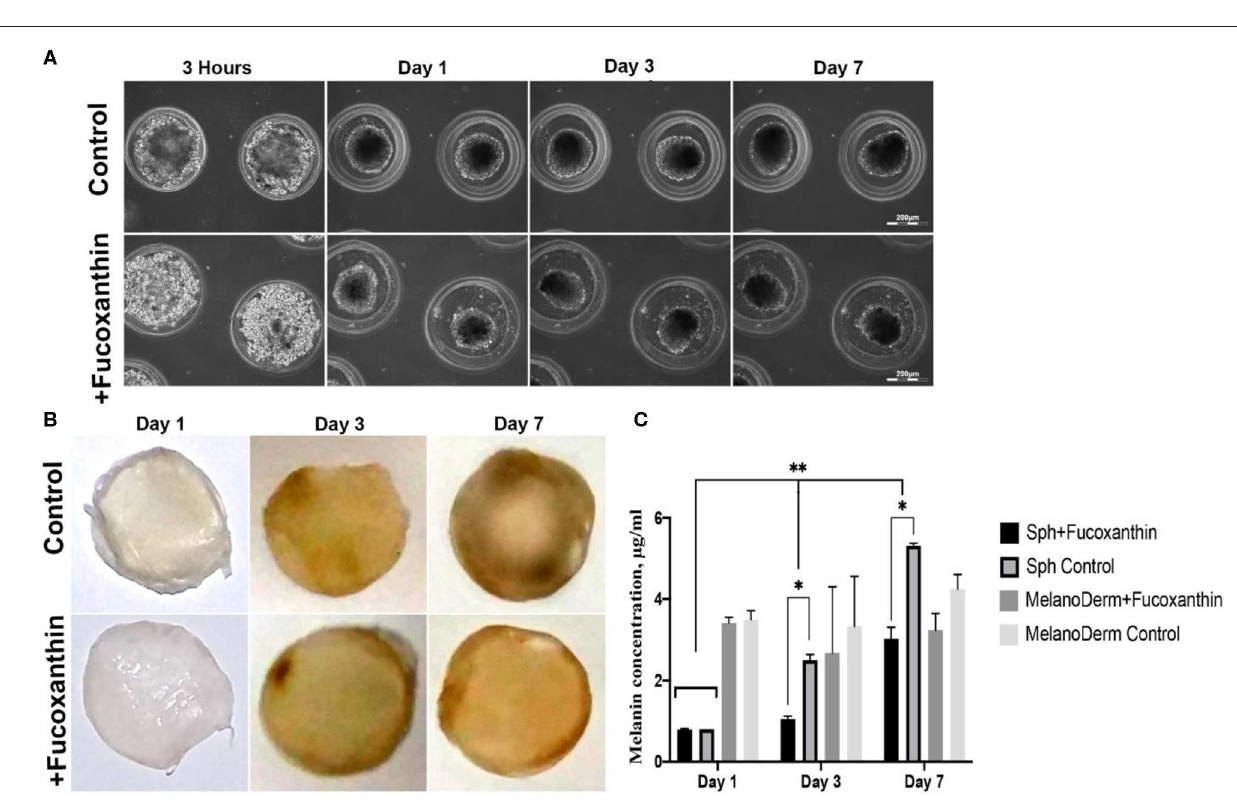
FIGURE 2 | Pigmentation of treated and untreated spheroids and skin equivalents. (A) Dynamics of the spheroid formation from a suspension of melanocytes under non-adhesive 3D conditions in a standard growth medium (control) and with the addition of fucoxanthin (experimental group). Phase-contrast live time-lapse microscopy (Cell-IQ, CM Technologies, Finland). (B) Pigment accumulation in MelanoDerm TM tissue equivalents at Days 1, 3, and 7 in the control group and the experimental group with the addition of fucoxanthin. All samples had the standard size − 9mm. Photos of samples dried before photometric analysis of melanin content. (C) Dynamics of melanin accumulation in melanocyte spheroids and MelanoDerm TM tissue equivalents in the presence of the lightening agent fucoxanthin (experimental group) and with a solution of sodium chloride (control group). * p < 0.05 for two-way ANOVA assay and multiple t -test. *, ** p < 0.05 (*within one time-point, **between different